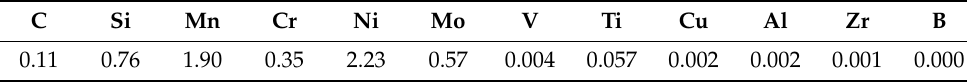
Table 4. Chemical composition of filler metal (UNION X96) in mass percent.